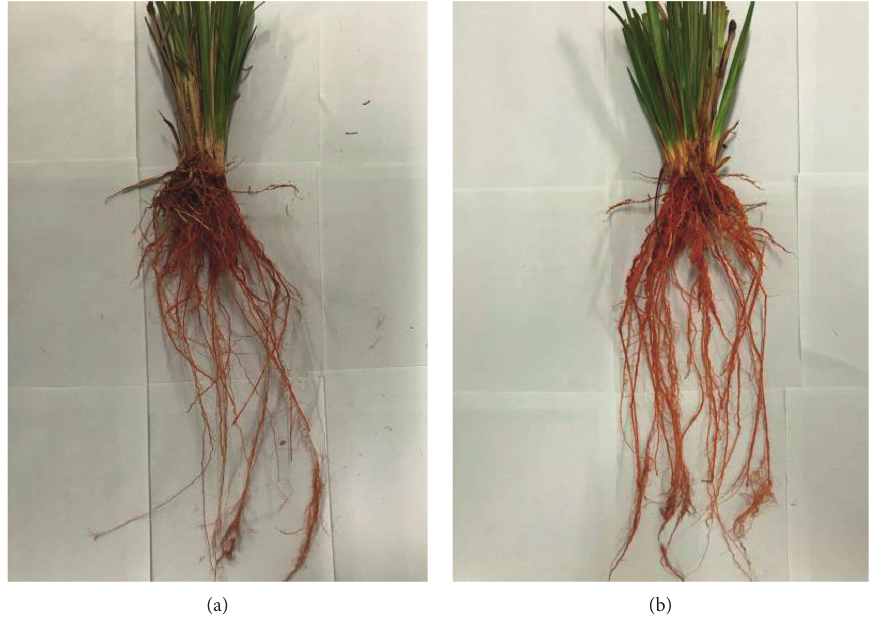
Figure 5: Root distribution: (a) 90d; (b) 180d.